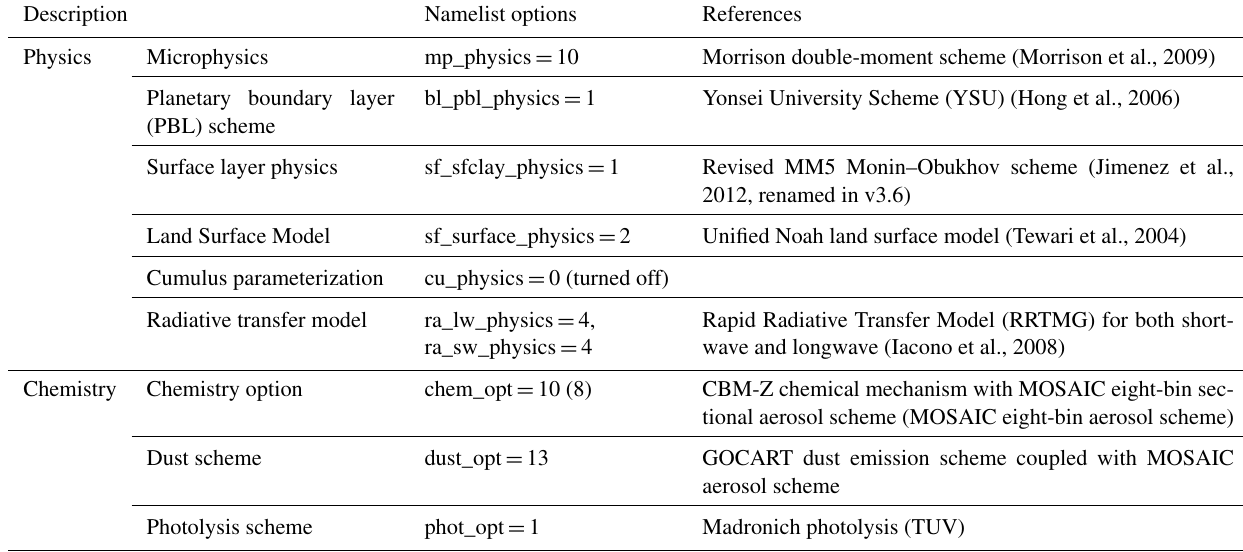
Table 1. Physics and chemistry namelist settings used in